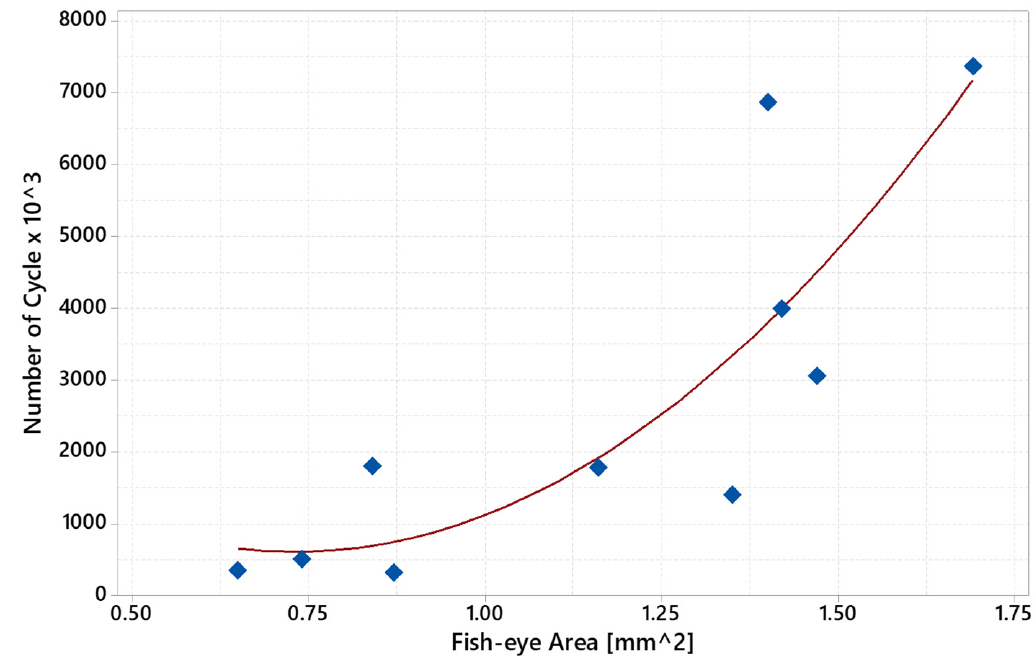
Figure 14. Scatter Plot of the correlation between fish-eye area and number of cycles.